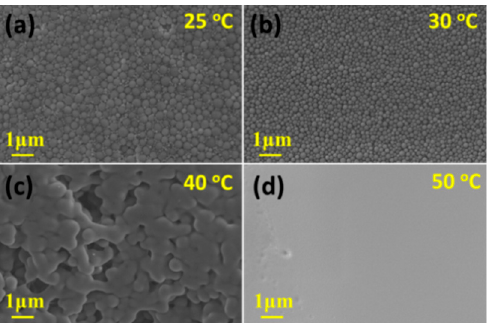
Figure 9. SEM images of DEaTIPS samples at different evaporation temperature: ( a ) 25 °C, ( b ) 30 °C, ( c ) 40 °C and ( d ) 50 °C.